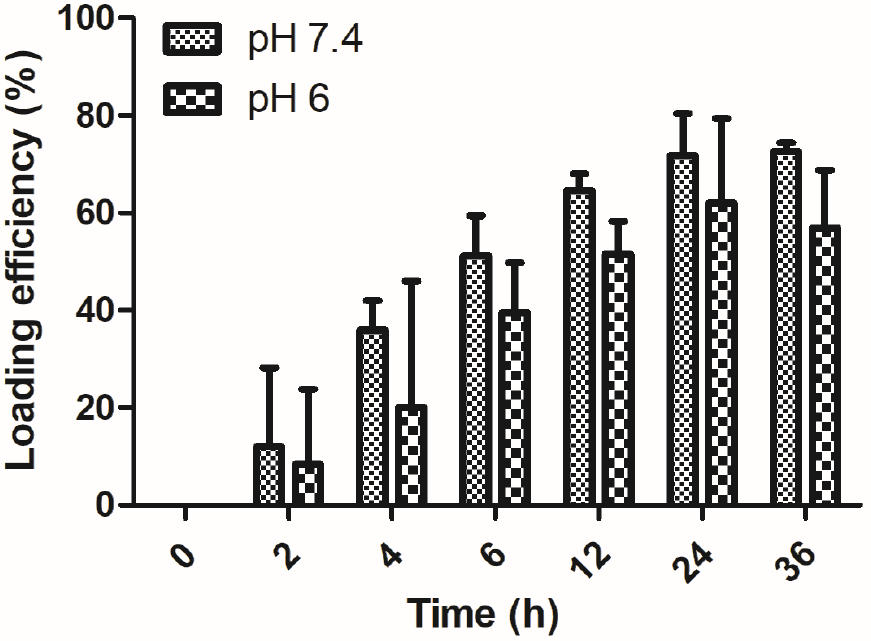
Figure 8. BSA loading efficiency of polyacrylic acid/ Schizochytrium sp. (PAA/Schizo)